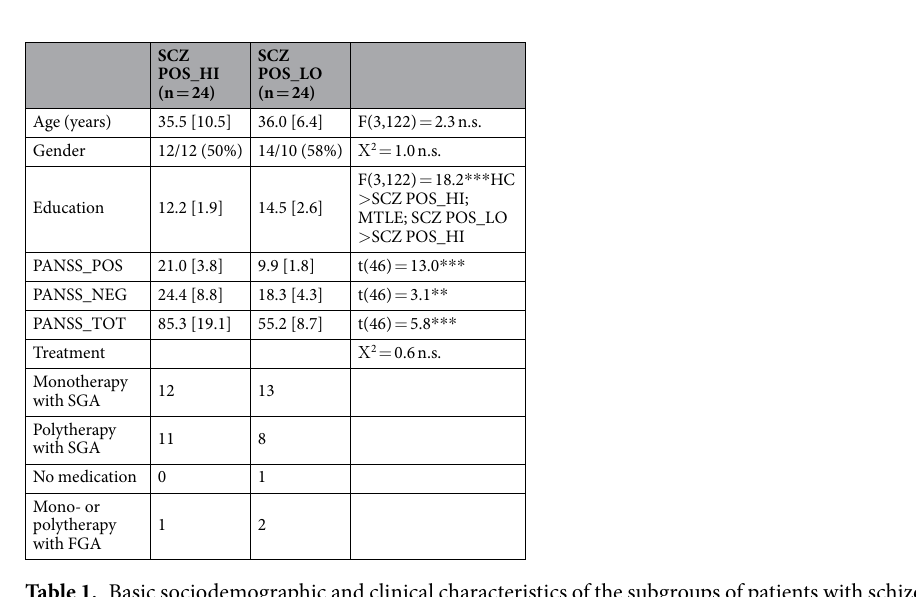
Figure 1. Results of cognitive (number of items coded for Digit Symbol; time in seconds for TMT-B) and mind-reading (number of items classified correctly in RMET) assessment. Error bars are for standard deviations. SCZ – patients with schizophrenia; MTLE – patients with temporal lobe epilepsy; HC – healthy controls.